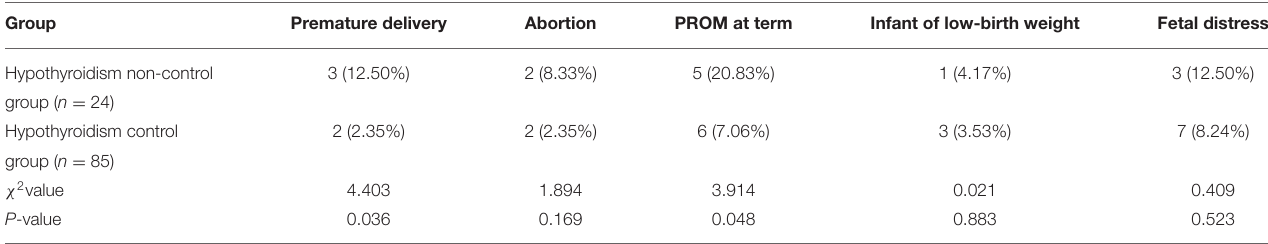
TABLE 1 | Comparison of adverse pregnancy outcomes between the two groups ( n ,%). Group Premature delivery Abortion PROM at term Infant of low-birth weight Fetal distress Hypothyroidism